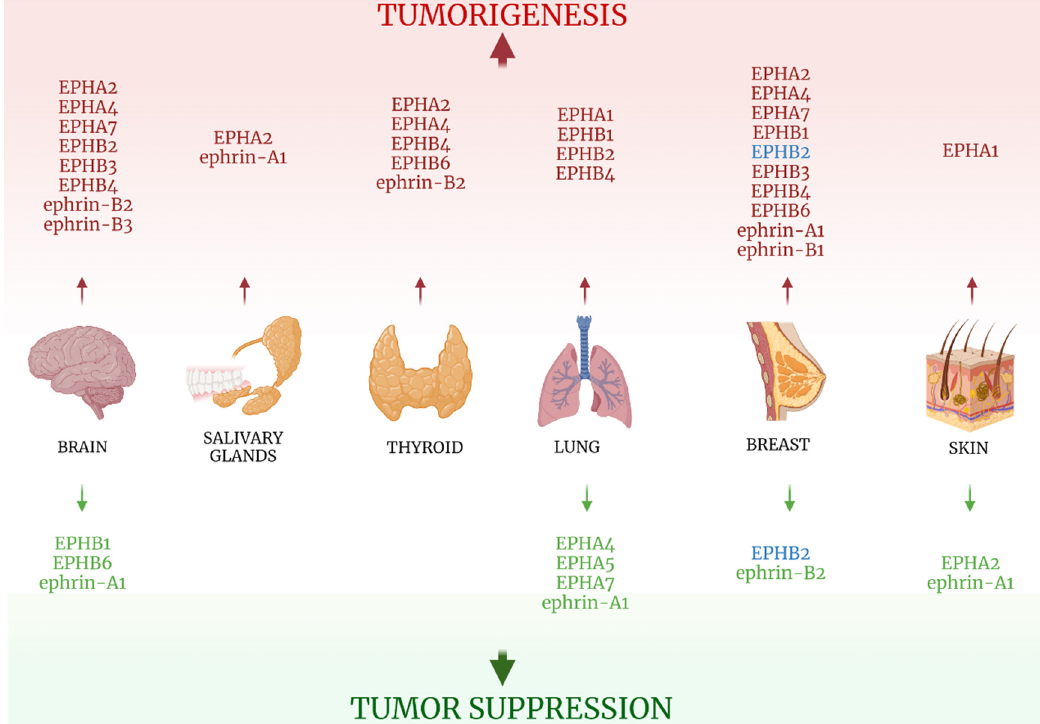
Figure 3. EPH/ephrin family role in solid tumors of the brain, salivary glands, thyroid, lung, breast, and skin. Red-colored EPHs/ephrins enhance tumorigenesis, while green-colored ones suppress it. EPHB2 in breast cancer can play both roles, depending on its location: cytoplasmic EPHB2 expression promotes carcinogenesis, while membranous EPHB2 expression favors tumor-suppression. Created with BioRender.com (accessed on 2 August